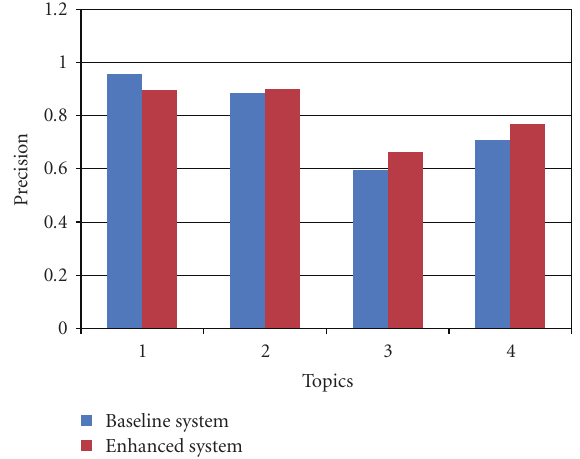
Figure 16: Precision for the results of the baseline and enhanced systems.